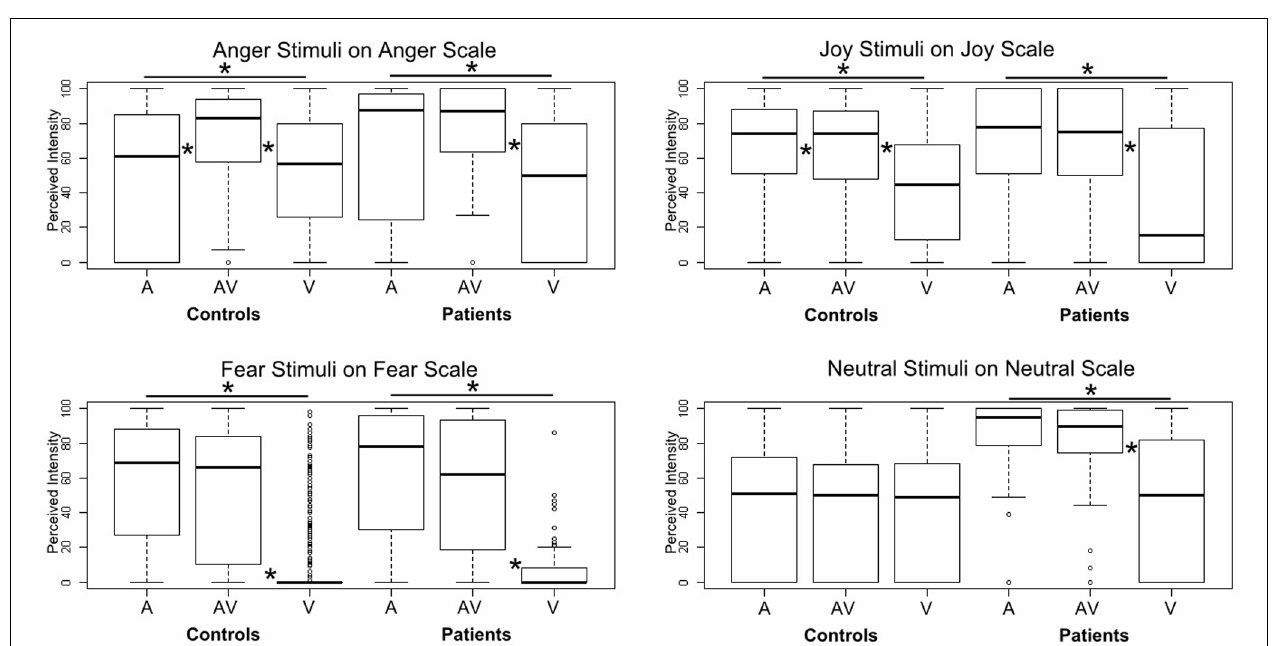
vs. controls).The difference between A and AV for the controls is almost invisible, as zero values data were included in the plot. *Indicates a significant difference between modalities